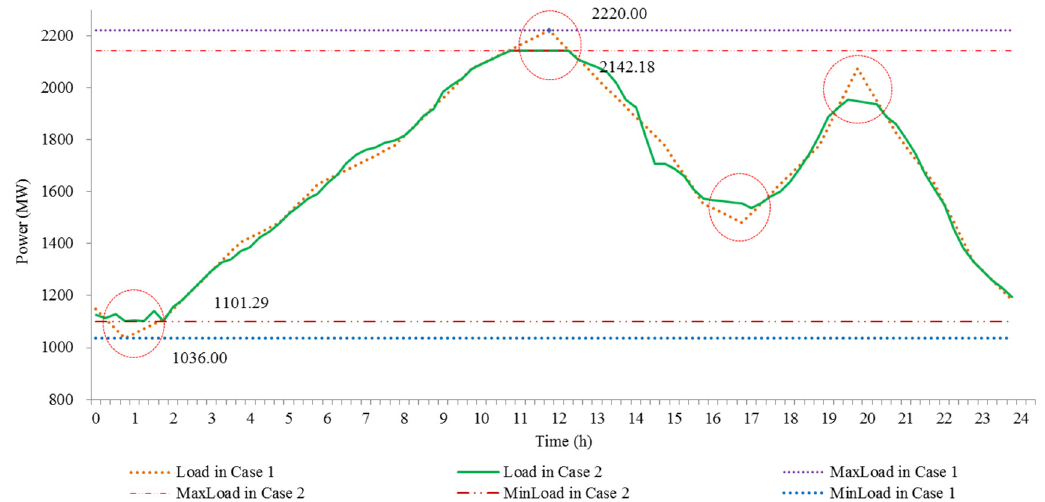
Figure 9. Load curves of Case 1 and Case 2 with 0.9 confidence degree. Energies 2018 , 11 , x